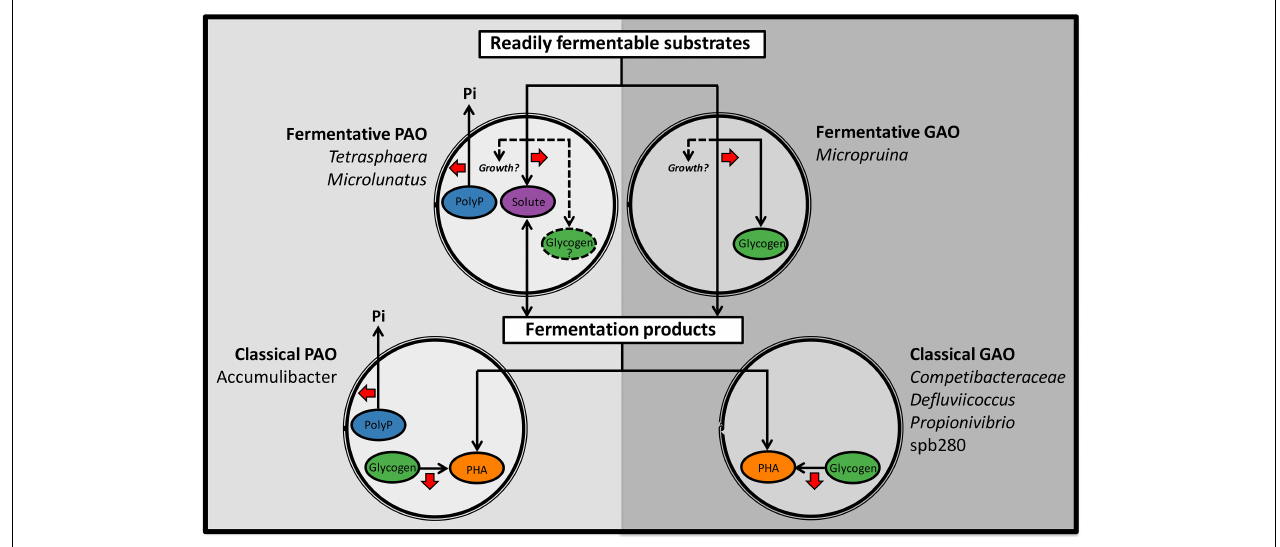
FIGURE 4 | Schematic diagram summarizing the important anaerobic transformations for known phenotypes with suggested importance to EBPR. Abundant phylotypes are included for each phenotype. Phenotypes to the left (PAO) favor EPBR and those to the right (GAO) are suggested to be detrimental to the process. Red arrows indicate net energy generation. In brief, the fermentative PAO (fPAO) compete with the fGAO and other fermenters for fermentable substrates (such as sugars and amino acids) and the classical PAO and GAO compete for fermentation by-products (such as VFAs). The Micropruina spp., and other potential fGAO, store some carbon as glycogen. The Tetrasphaera spp. and Microlunatus fPAO reportedly store some carbon as non-polymerized fermentation by-products and have the potential for glycogen storage (Santos et al., 1999; Kristiansen et al., 2013; Nguyen et al., 2015; Nguyen, H., and Nielsen, P.H., unpublished